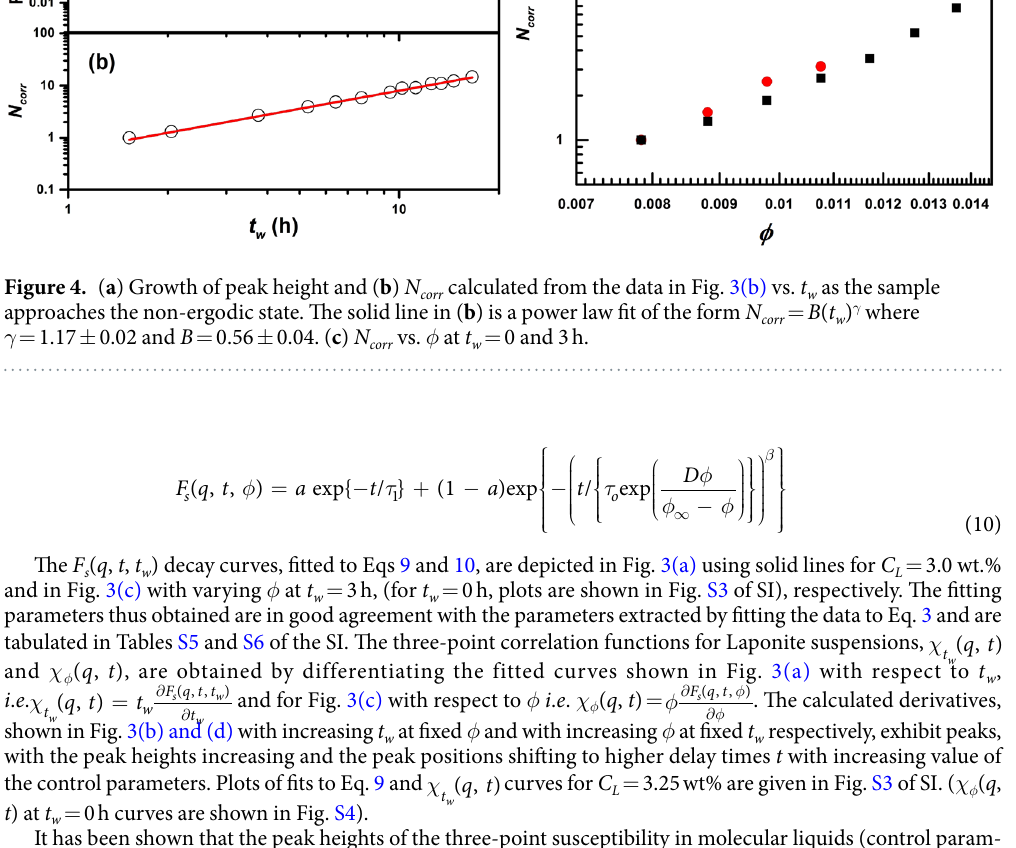
The F s ( q , t , t w ) decay curves, fitted to Eqs 9 and 10, are depicted in Fig. 3(a) using solid lines for C L = 3.0 wt.% and in Fig. 3(c) with varying φ at t w = 3 h, (for t w = 0 h, plots are shown in Fig. S3 of SI), respectively. The fitting parameters thus obtained are in good agreement with the parameters extracted by fitting the data to Eq. 3 and are tabulated in Tables S5 and S6 of the SI. The three-point correlation functions for Laponite suspensions, χ q t ( , ) t w and χ φ ( q , t ), are obtained by differentiating the fitted curves shown in Fig. 3(a) with respect to t w , ∂ F q t ( , , ) s . The calculated derivatives, F q t t ( , , ) s w i . e . χ = ∂ and for Fig. 3(c) with respect to φ i . e . χ φ ( q , t ) = φ φ q t t ( , ) t w ∂ ∂ φ t w w shown in Fig. 3(b) and (d) with increasing t w at fixed φ and with increasing φ at fixed t w respectively, exhibit peaks, with the peak heights increasing and the peak positions shifting to higher delay times t with increasing value of the control parameters. Plots of fits to Eq. 9 and χ q t ( , ) curves for C L = 3.25 wt% are given in Fig. S3 of SI. ( χ φ ( q , t w t ) at t w = 0 h curves are shown in Fig. S4). It has been shown that the peak heights of the three-point susceptibility in molecular liquids (control param- eter T ) and hard sphere colloids (control parameter φ ) contain information of N corr . The peak heights of three point susceptibilities deduced in the present case with t w as control parameter at fixed φ and with φ as control parameter at fixed t w can therefore be expected to contain information on N corr for the aging Laponite suspensions and χ φ ( q , t ), with increasing t w or increasing φ studied here. The observed growth of the peak height of χ q t ( , ) t w establish the growing dynamical heterogeneities and the monotonically increasing trend of N corr during the spon- taneous aging process of Laponite colloidal suspensions. The height of the peaks, plotted in Fig. 4(a) (for C L = 3.0  are cal- wt.%) as a function of t w , is proportional to N corr 15 . Next, ∝   culated with the assumption that for the smallest waiting times or lowest φ , correlated particle motion can be ruled out (with particles moving independently, i . e . N corr = 1). Here, normalization is carried out with the peak height at t w = 1.5 h for t w dependent study of C L = 3.0 wt % or with φ = 0.008 ( C L = 2.0 wt %) for φ dependent data to obtain N corr . Since at t w = 1.5 h and φ = 0.008, the stretching exponent, β is close to one and the distribution function of relaxation times G ww peaks close to τ / τ ww = 1 as shown in Fig. 2 (for t w = 1.5 h, β = 0.94 ± 0.01 and = 1.18, just starting to deviate from unity). τ / τ τ / τ ww ww close to one suggests the presence of a unique relaxation time and the absence of correlated motion of the particles in suspension. The proportionality pre-factors in the relation for N corr can be assumed to be independent of t w at fixed φ as number density of Laponite particles is constant. It is to be noted here that there exists initial osmotic swelling of Laponite particles during preparation of suspensions due to hydration which is followed by build up of electrostatic repulsive interactions between the particles 23 . Therefore, over the range of aging times probed in the present experiments, the osmotic pressure and   ∂ ( ) t F q t t ( , , ) s w is normalized with respect to the value at the values of k T is expected to be constant. Finally,   w ∂   t w t w = 1.5 h at all t w to obtain N corr as a function of t w for C L = 3.0 wt.%. The corresponding N corr plot is given in Fig. 4(b). N corr obtained with increasing φ is shown in Fig. 4(c) at t w = 0 and 3 h. We observe a small increase in N corr at t w = 0 h with increasing φ and obtain a large N corr at high φ at higher t w ( = 3 h). This is because samples of higher concentration reach the non-ergodic state at lower t w . Growth of peak height and N corr for C L = 3.25 wt.% are plotted in SI (Fig. S5) and similar trends were observed as C L = 3.0 wt. %. If τ g = 10 s is defined as the non-ergodic transition point 15 , a monotonic growth of N corr with increasing t w is observed. The growth of N corr shows a power law dependence on t w ( N corr = B ( t w ) γ , where the exponent γ = 1.17 ± 0.02, B = 0.56 ± 0.04) and is shown by a solid line in Fig. 4(b) for C L = 3.0 wt.%. Similar power law growth of N corr is observed for measure- ments (upto t w = 9.6 h ) performed at a lower scattering angle θ = 75° ( q = 1.9 × 10 − 2 nm − 1 ) and 60°